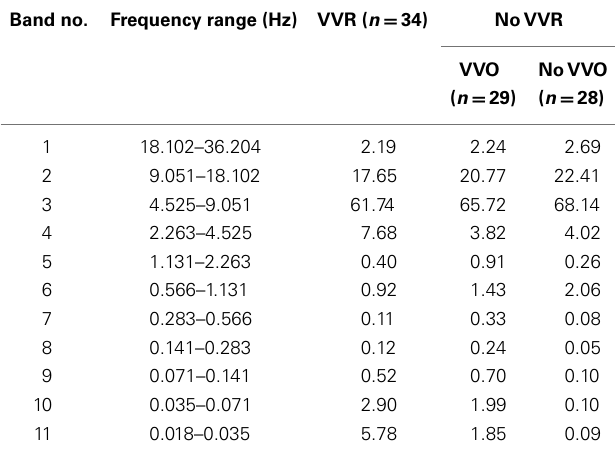
Table 1 | Power distribution induced by sGVS in three conditions:VVO andVVRs, onlyVVO, noVVO and